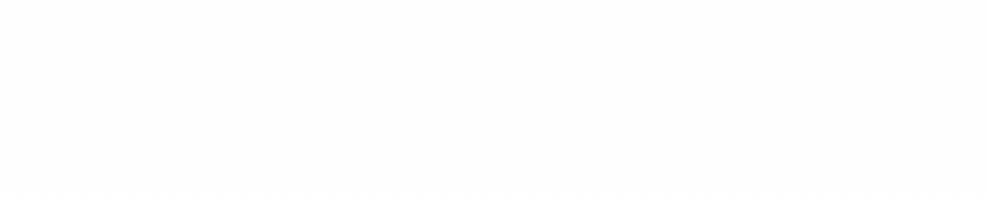
tennae testaceous. Front white. Palpi black margined with white below. Collar black with a large white spot on the middle and a smaller one on either side at the base of the wings. Tegulae black rnargined with